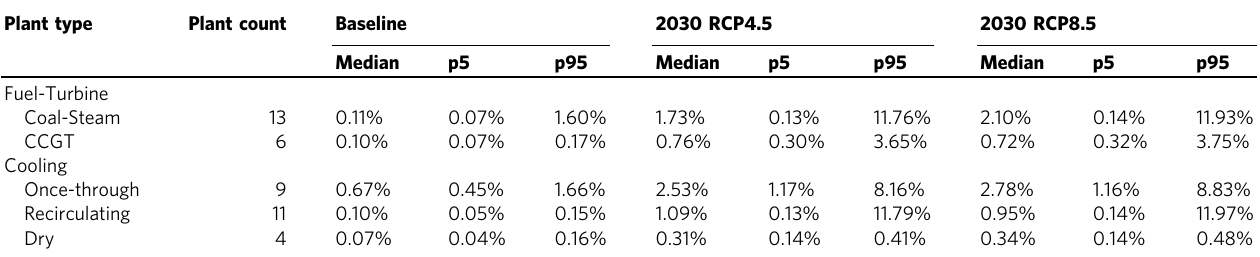
Table 3 Ensemble statistics of plant-level physical climate risk-induced generation losses by generation type and by cooling